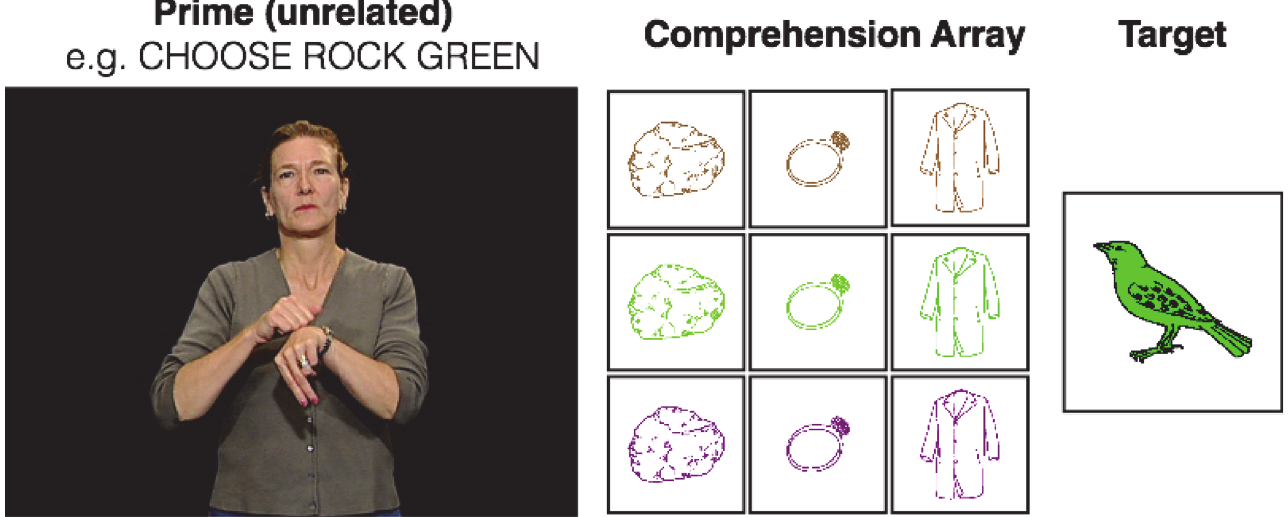
Fig 1. Example stimulus array during a syntactic priming trial. A video of the stimulus model signs the prime “ CHOOSE ROCK GREEN. ” The participant (not shown) chooses from an array of 3 different objects shown in 3 different colors. Next appears the target, which can be described as BIRD GREEN (post- nominal) or GREEN BIRD (pre-nominal). The individual in this figure has given written informed consent (as outlined in PLOS consent form) to publish these case details.